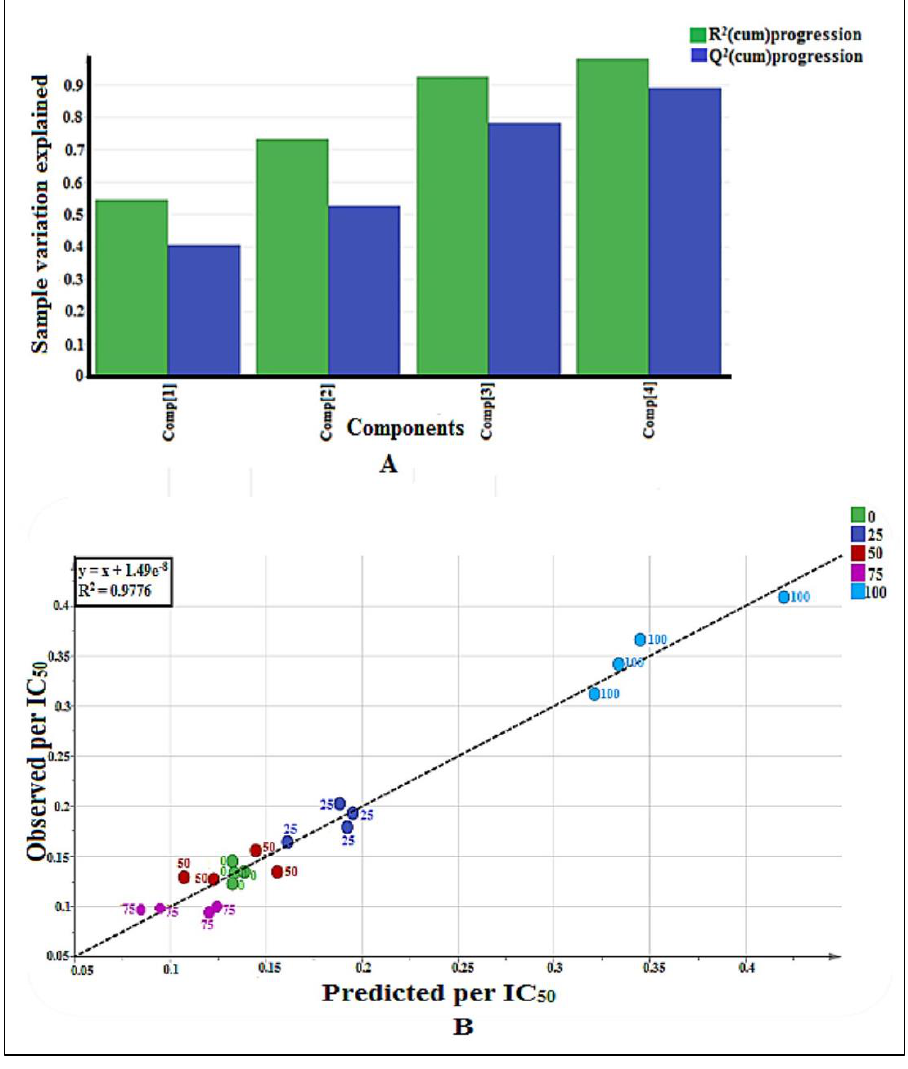
Figure 1. ( A ) Summary of fit of established PLS model for P. malayana leaves extracts ( n = 4), where four components involved and this plot indicates the fitness of the model. ( B ) Observed vs. predicted AGI activity with R 2 value 0.9776 from 20 extracts of P. malayana leaves ( n = 4), indicates the model is